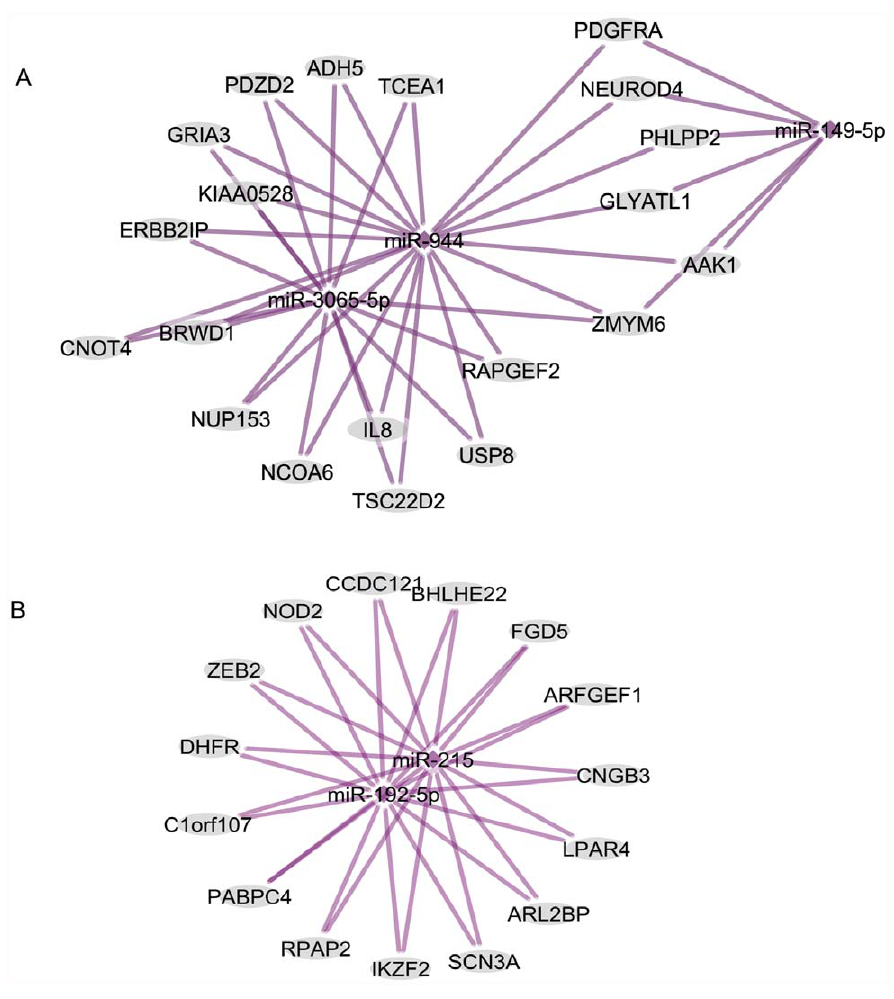
Figure 3. Prediction of target genes for similarly regulated miRNA. Note that miR -3065, -944 and -149-5p all were down-regulated and share multiple common targets (Panel A) and miR-192 and -215 all were up-regulated and share common targets (Panel B). These results of common targets for similarly up- or down- regulated miRNA suggest coordination between miRNA.